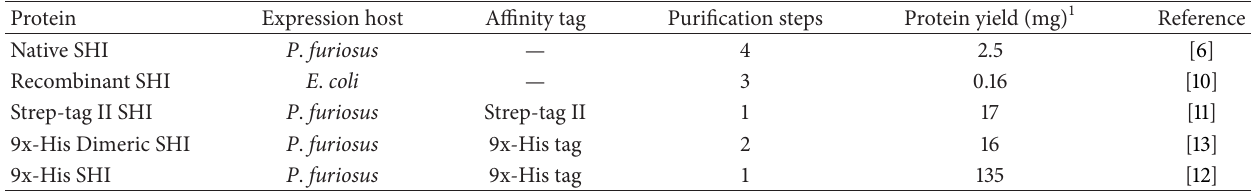
Table 1: Yields of SHI from different expression